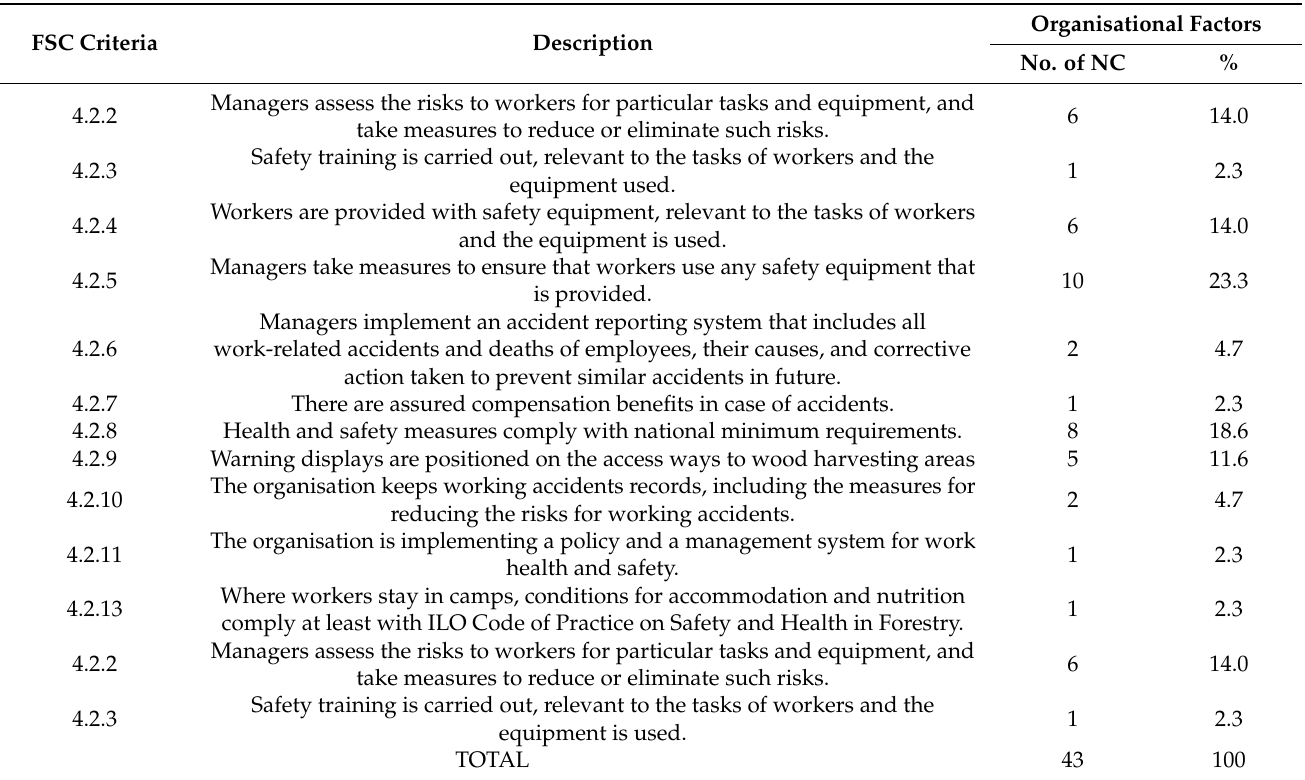
Table 3. Analysis of the organisational risk factors category related NCs and their relation to the FSC